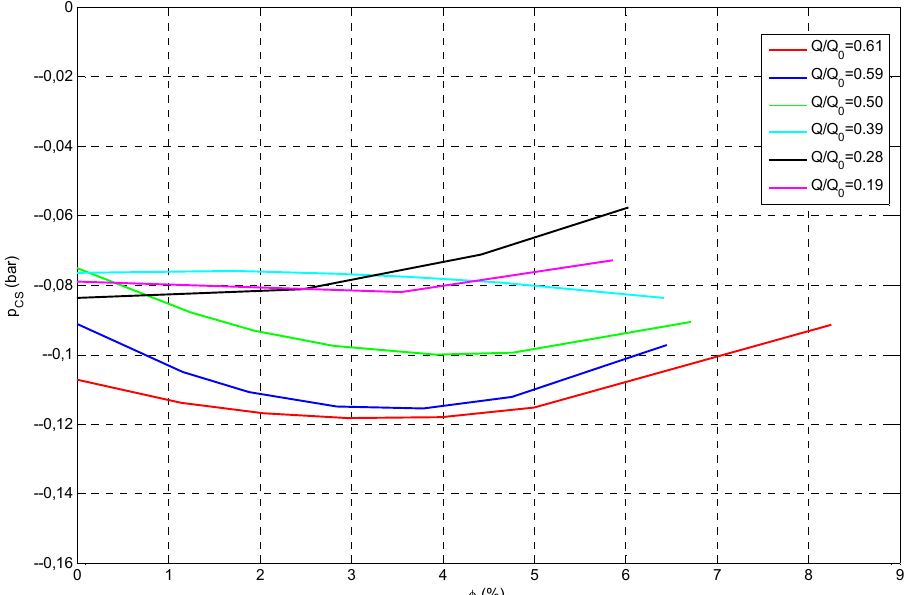
Figure 7. The pressure variation in the turbine draft tube cone section for the investigated operation regimes, with and without air injection.